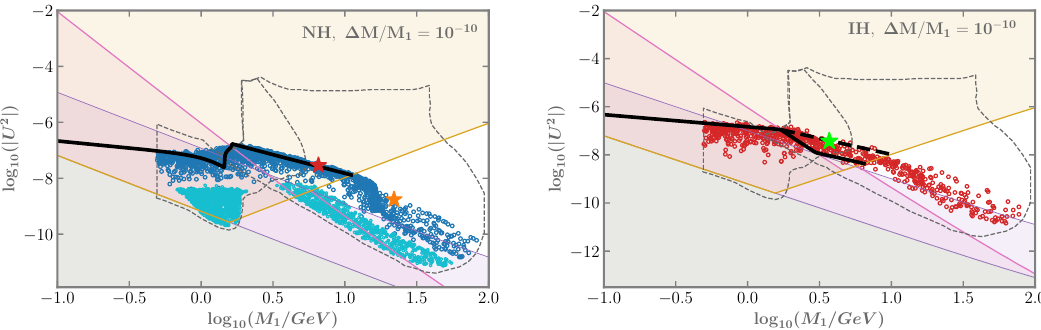
Figure 8 . Result of the numerical scan for ∆ M/M = 10 − 10 shown in blue (red) for NH (IH) with standard priors in the phases. For NH, we include in lighter blue the result obtained using priors for the phases that are flat in a logarithmic scale. The black lines represent the analytical upper bound on the mixing, while the dashed for IH is the conservative bound described in the text. The stars indicate benchmark points, see main text. Color coding for the shaded regions as in figure